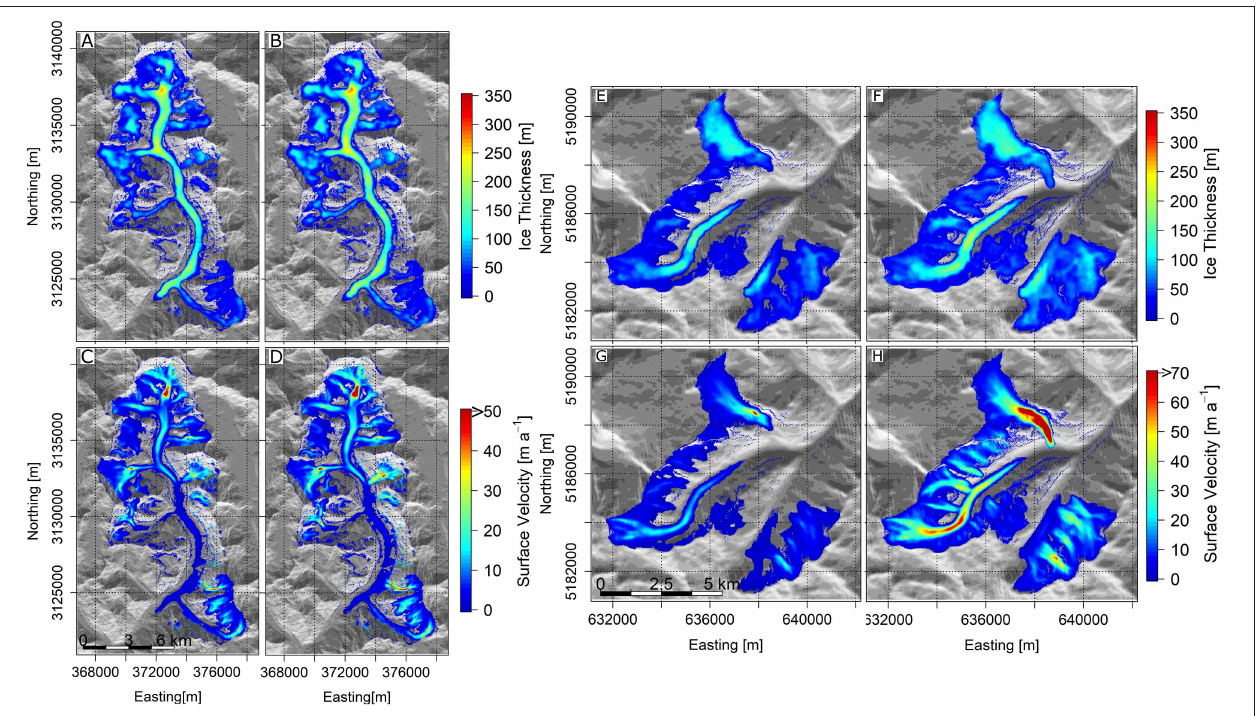
FIGURE 10 | Ice thickness and surface velocity fields of the Langtang Glacier (A–D) and Hintereisferner (E–H) , showing modeled ice thickness/velocity in 2016 for the cold/wet (Langtang Glacier) and cold/dry (Hintereisferner) FULL (A,C,E,G) and NATURAL scenarios (B,D,F,H)